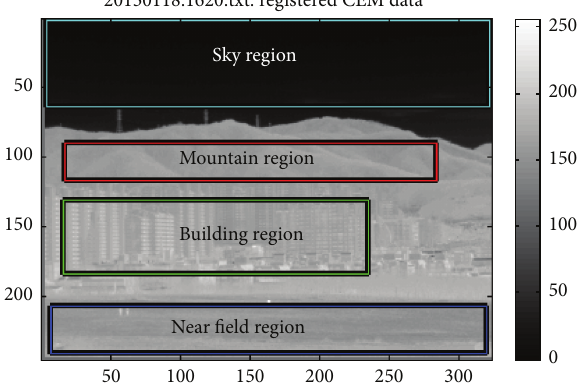
Figure 11: Analysis regions indicated on the